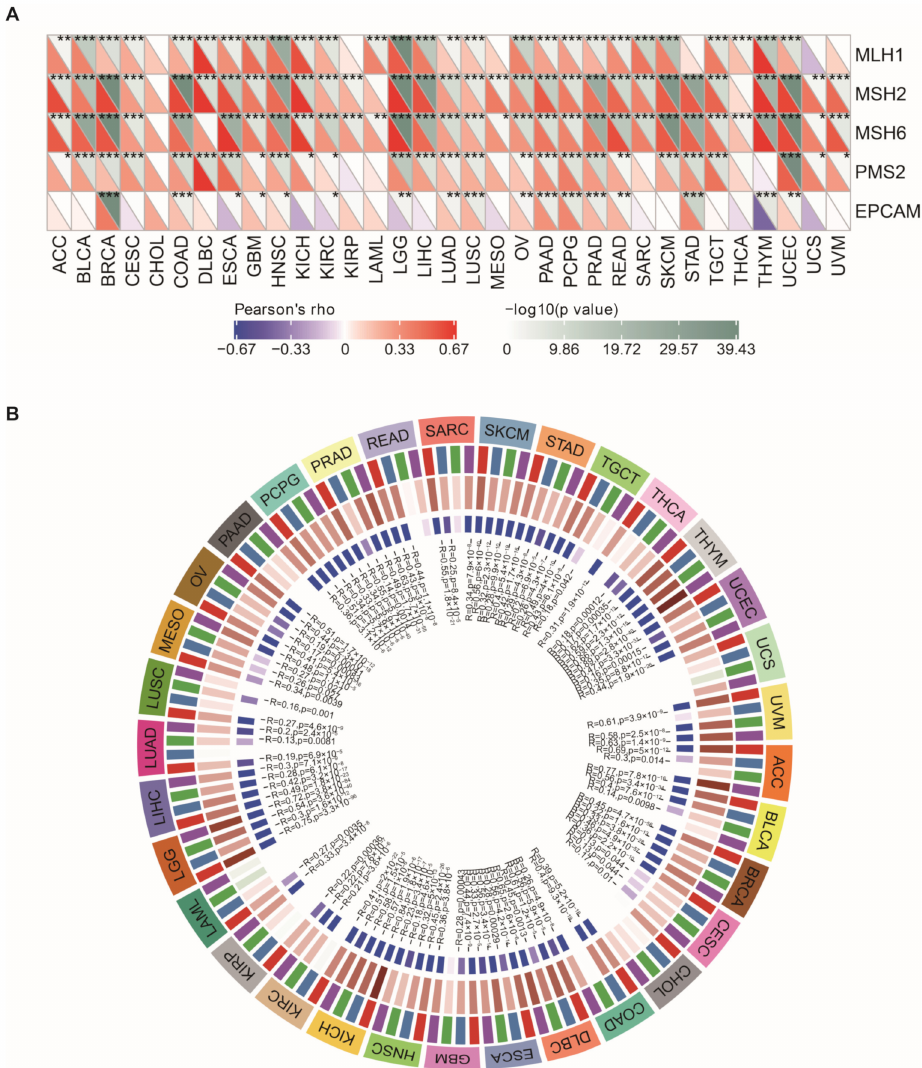
Figure 9. NEIL3 expression is correlated with MMR and DNA methyltransferase genes in multiple cancers. Correlation between NEIL3 expression level and ( A ) mutation of five MMR genes, namely, MLH1, MSH2, MSH6, PMS2, and EPCAM; ( B ) expression of four DNA methyltransferase genes, namely, DNMT1 (red), DNMT2 (blue), DNMT3A (green), and DNMT3B (purple), in various cancers. The innermost brown and blue circles represent the R and p values of the correlation analysis, respectively. * p < 0.05, ** p < 0.01, *** p <